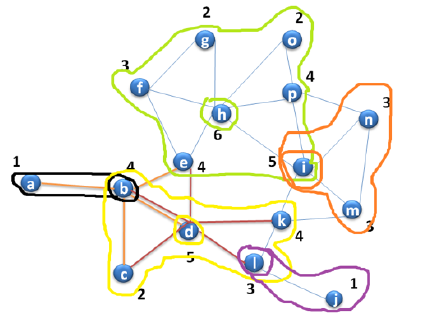
Fig. 2. Cluster head selection and Clusters formation ( Clusters construction and cluster